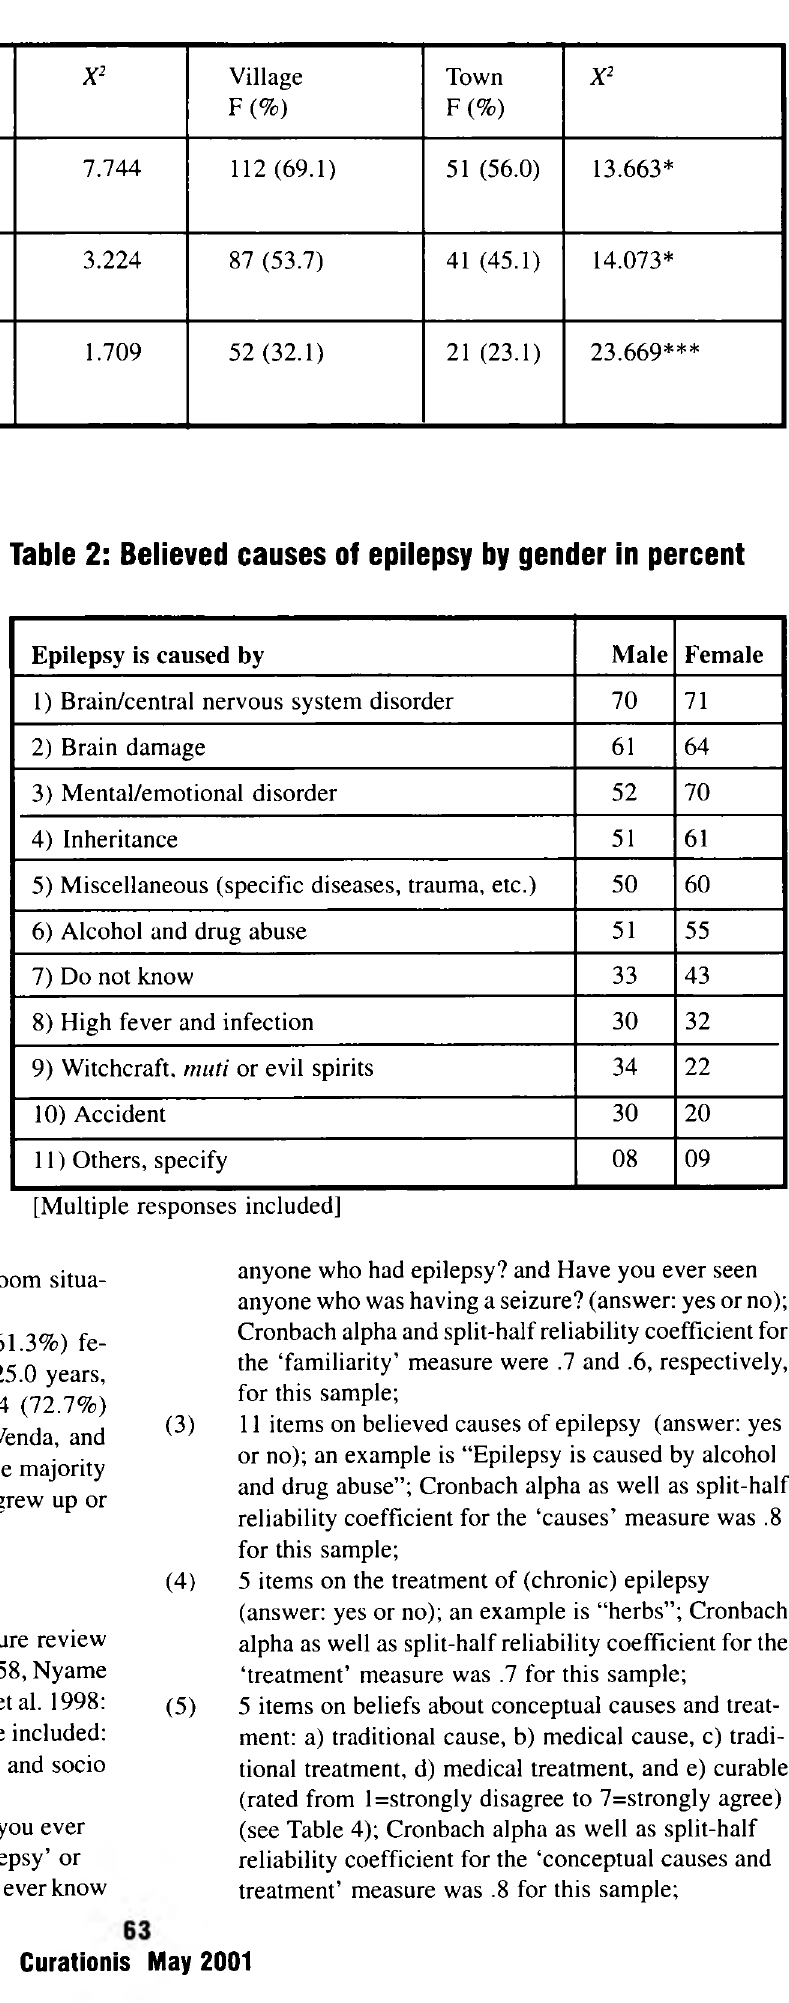
Table 1 : Familiarity with epilepsy by gender and urbanisation level.